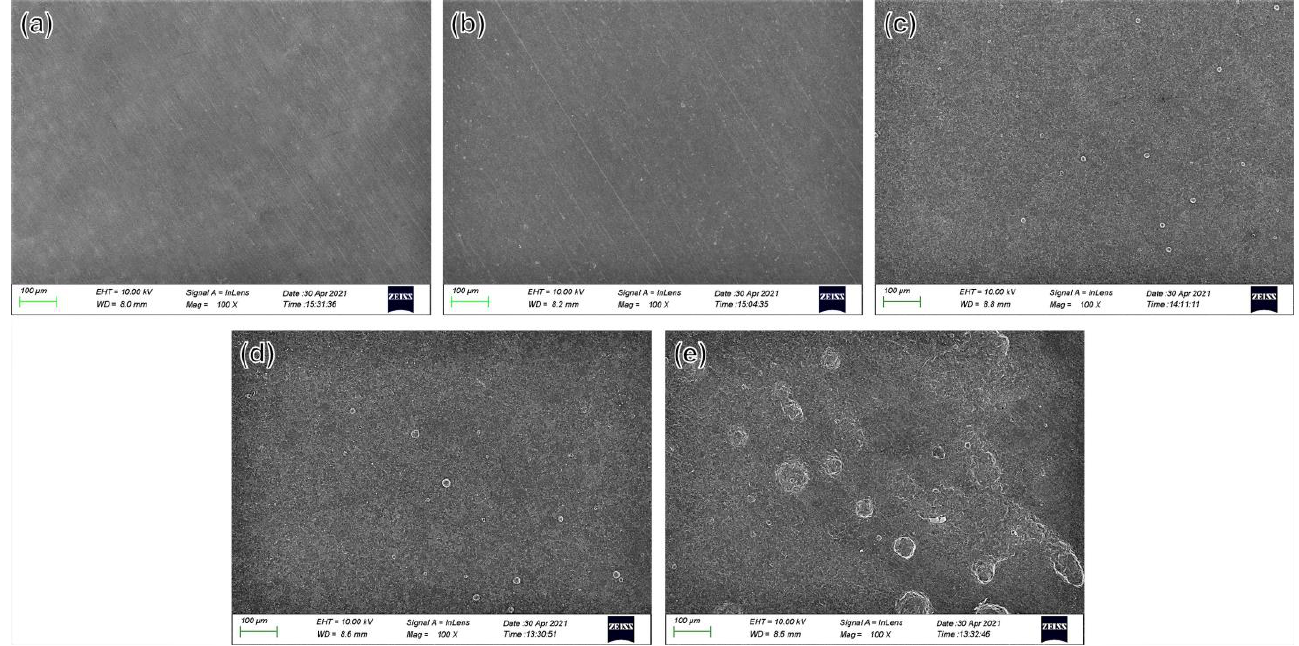
Figure 13. SEM images of the corrosion morphology of X80 steel samples after 2 h in NS4 solution under various DC densities with strain of 3 × 10 −3 . ( a ) i DC = 0 mA/cm 2 , ( b ) i DC = 0.25 mA/cm 2 , ( c ) i DC = 0.5 mA/cm 2 , ( d ) i DC = 1 mA/cm 2 . ( e ) i DC = 2 mA/cm 2